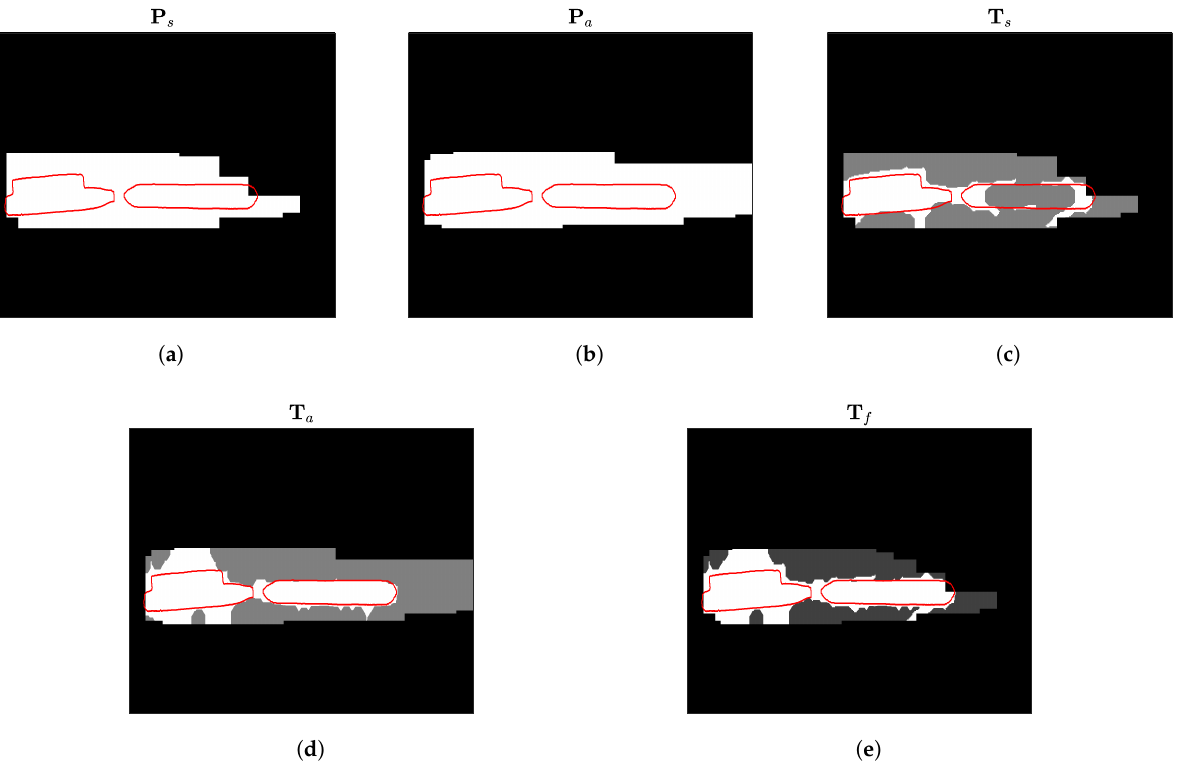
Figure 4. Illustrative example of TSPM generation: ( a ) Proposal matrix P s extracted from the spaceborne SAR image I s ; ( b ) Proposal matrix P a extracted from the airborne SAR image I a ; ( c ) TSPM T s with respect to I s ; ( d ) TSPM T a with respect to I a ; and ( e ) Intersected TSPM T f . The ground truth boundaries of vessel targets are also plotted as red lines. By using the intersected TSPM T f , we can significantly reduce the false alarms induced by the inshore interferences and sea clutter, while retaining the potential target regions in I s and I a